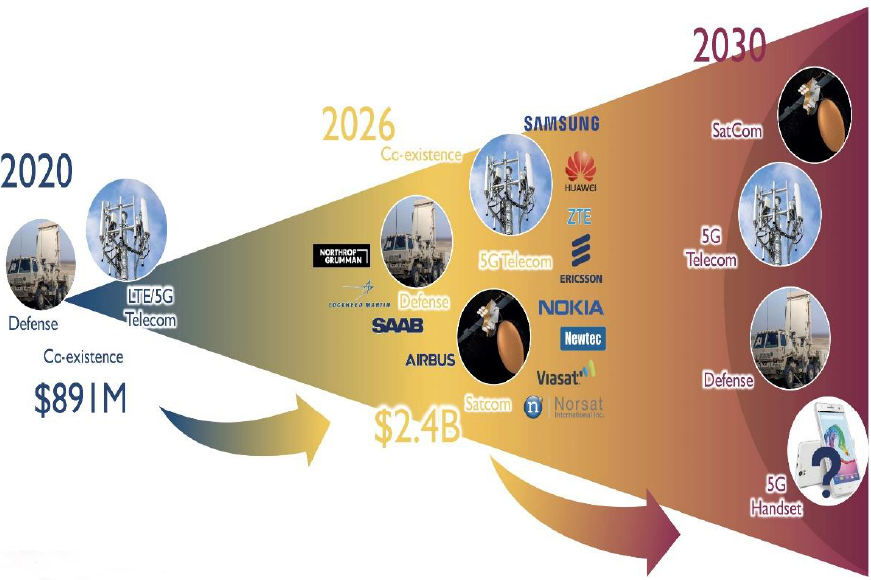
Figure 7. GaN Power RF market evaluation by Yole. Reproduced with permission [6]. Copyright 2021, published by Yole D é veloppement.